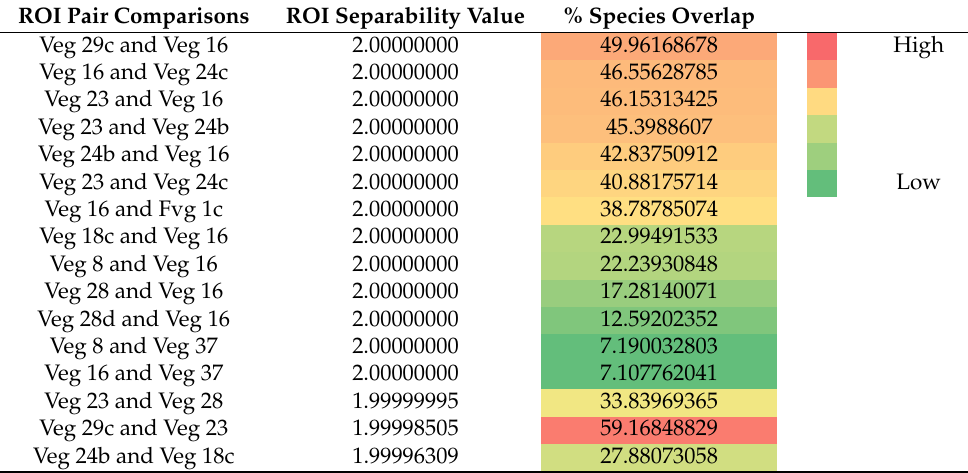
Table A3. Percentage overlap of vegetation species present in classification classes paired for compar- ison. The colour scheme ranges from red with the highest species overlap to green with the lowest species overlap between any two vegetation